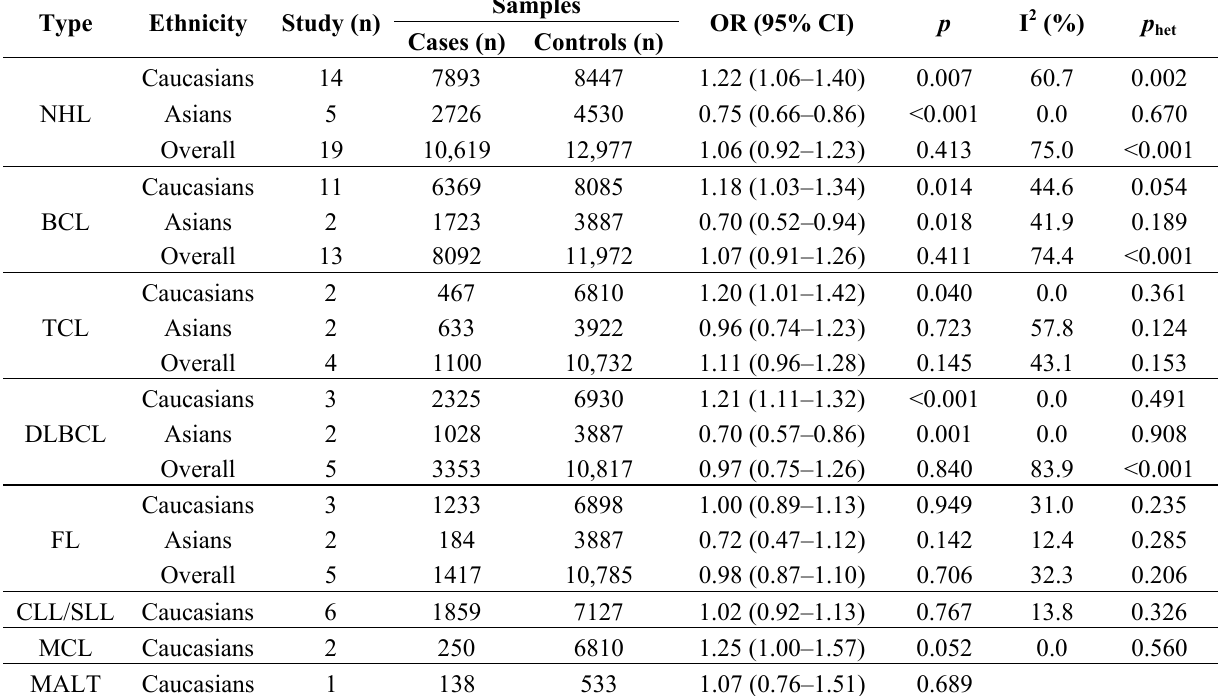
Table 2. Stratified analyses of TNF- α -308G/A polymorphism on NHL risk in Caucasians and Asians